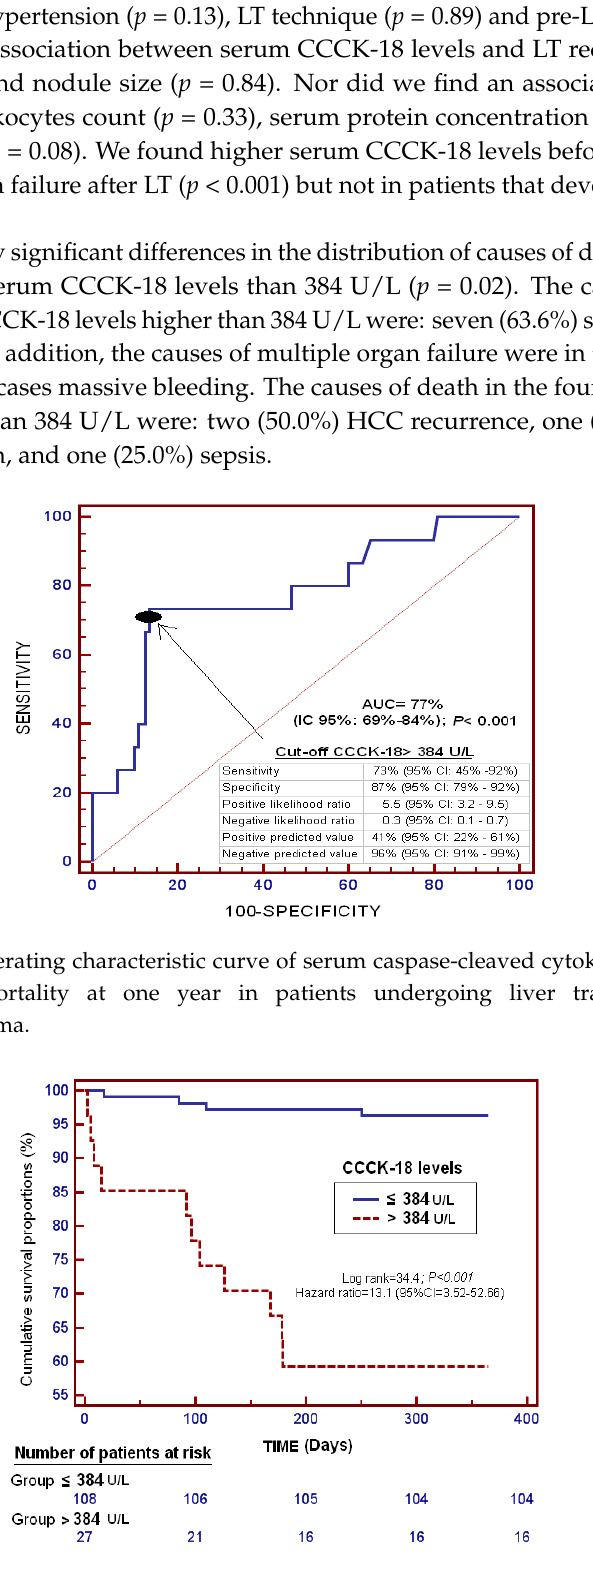
Figure 2. Survival curves at one year using serum caspase-cleaved cytokeratin (CCCK)-18 levels higher or lower than 384 U/L in patients undergoing liver transplantation for hepatocellular carcinoma.